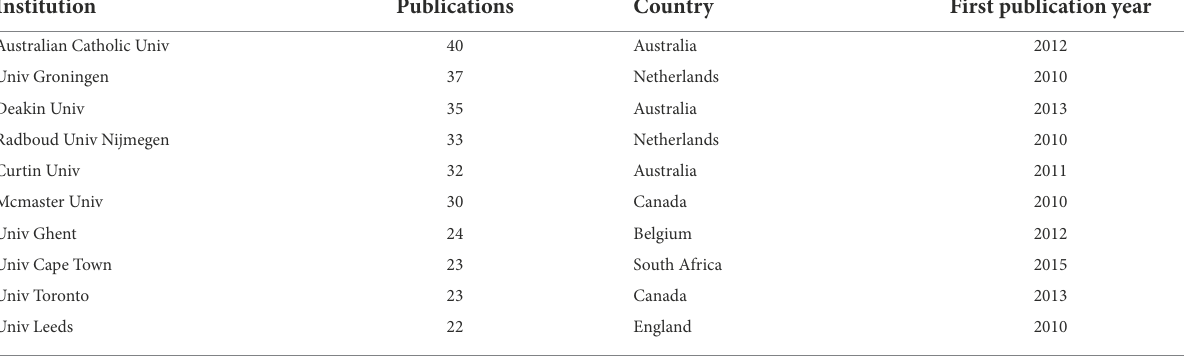
TABLE 2 Top ten institutions’ publication number, country, and first publication year. Institution